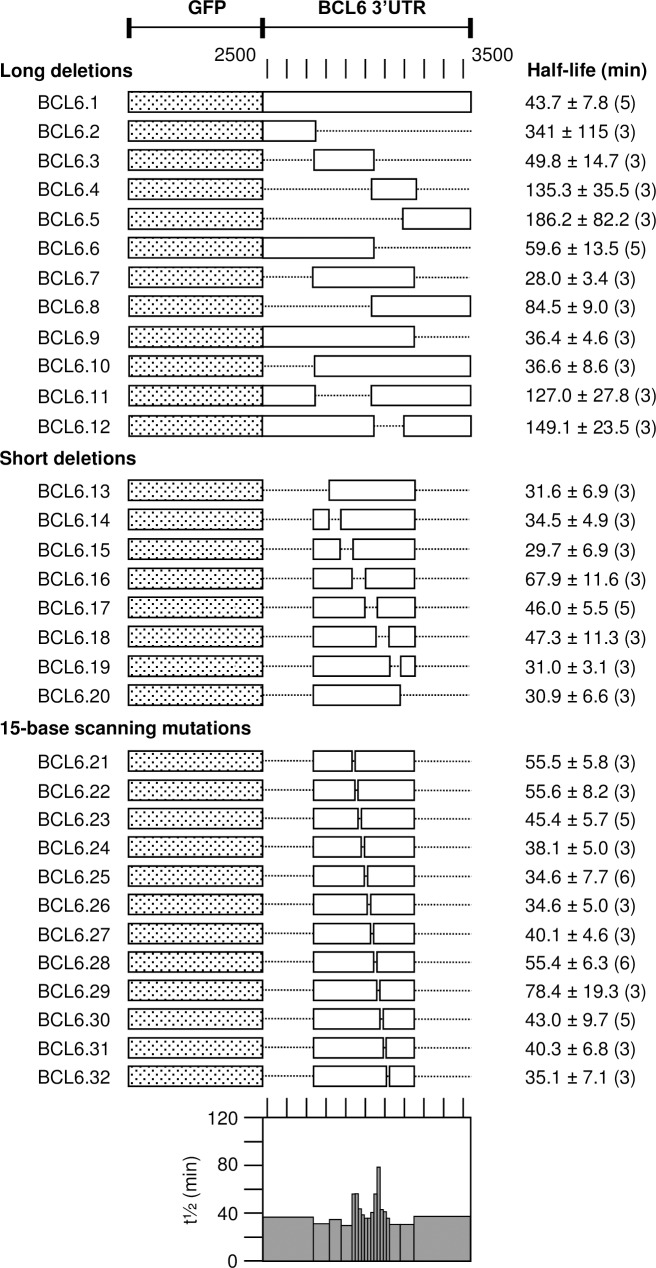
Identification of instability elements in BCL6.The 3’UTR of the human BCL6 sequence 2484–3529 (NM_001706.4) was amplified and inserted into pZPCTHI and stably transfected together with pBHTTA into NIH/3T3 cells. The sequence is followed by the polyadenylation signal of the bovine growth hormone gene. Mutants of the EGFP-BCL6 construct are described in detail in S3 Table and Materials and Methods. The mRNA half-life was determined by inhibition of the transcriptional transactivator, measuring the mRNA level at 8, 68 and 128 min after doxycycline addition in independently transfected cell cultures, the number of which is indicated for each construct in parenthesis. The first order decay was calculated by linear regression of semi-logarithmic plots. The graphical representation at the bottom summarizes the half-lives for each construct and the increase of mRNA stability in specific mutants.